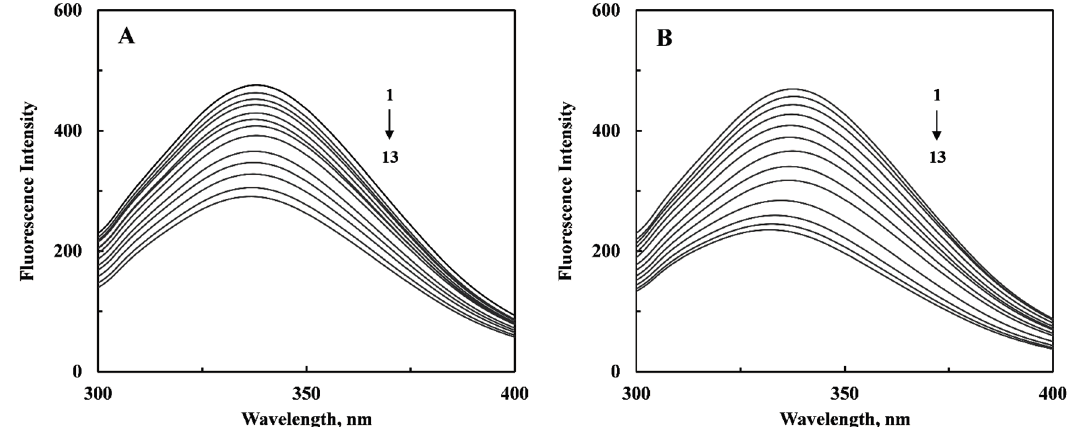
Figure 2. Emission spectra of human serum albumin (HSA) in the absence and the presence of increasing curcumenol ( A ) and curcumenone ( B ) concentrations, obtained in 20 mM sodium phosphate buffer, pH 7.4 upon excitation at 280 nm. [HSA] = 3 μ M, [Ligand] = (1–13): 0, 3, 6, 9, 12, 15, 18, 24, 30, 37.5, 45, 52.5 and 60 μ M. T = 25 °C.